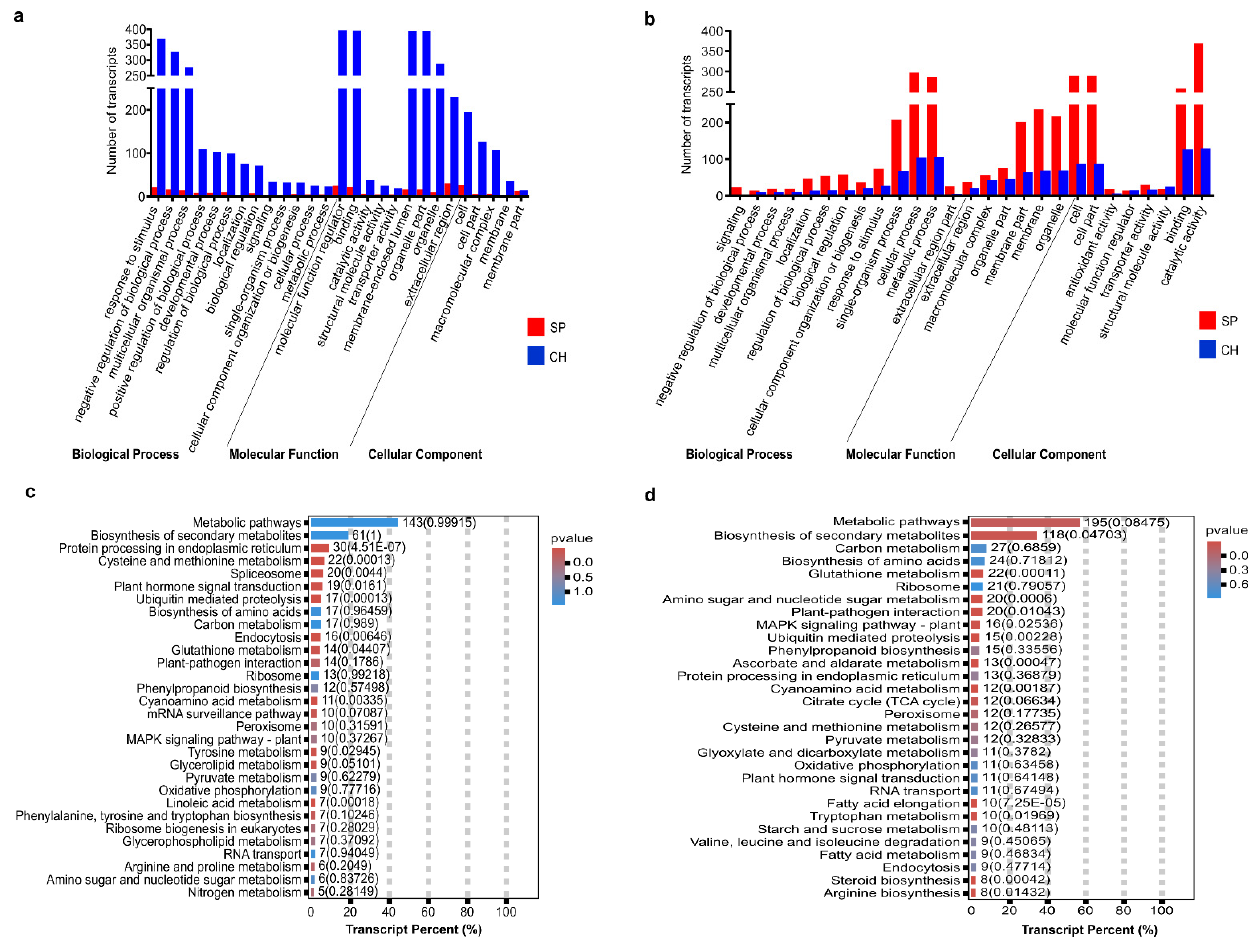
Figure 3. Analysis of DETs between BNF-contrasting genotypes that show a common pattern of regulation in stalks and hydroponics. ( a , b ) The figures show the number of differentially expressed transcripts that are more represented in GO categories. Red represents the number of the upregu- lated transcripts in SP, and blue in CH. ( a ) shows data of roots and ( b ) shows data of shoots. ( c , d ) The graphs show the KEGG enrichment analysis ( c ) in roots and ( d ) in shoots. Only the most rep-